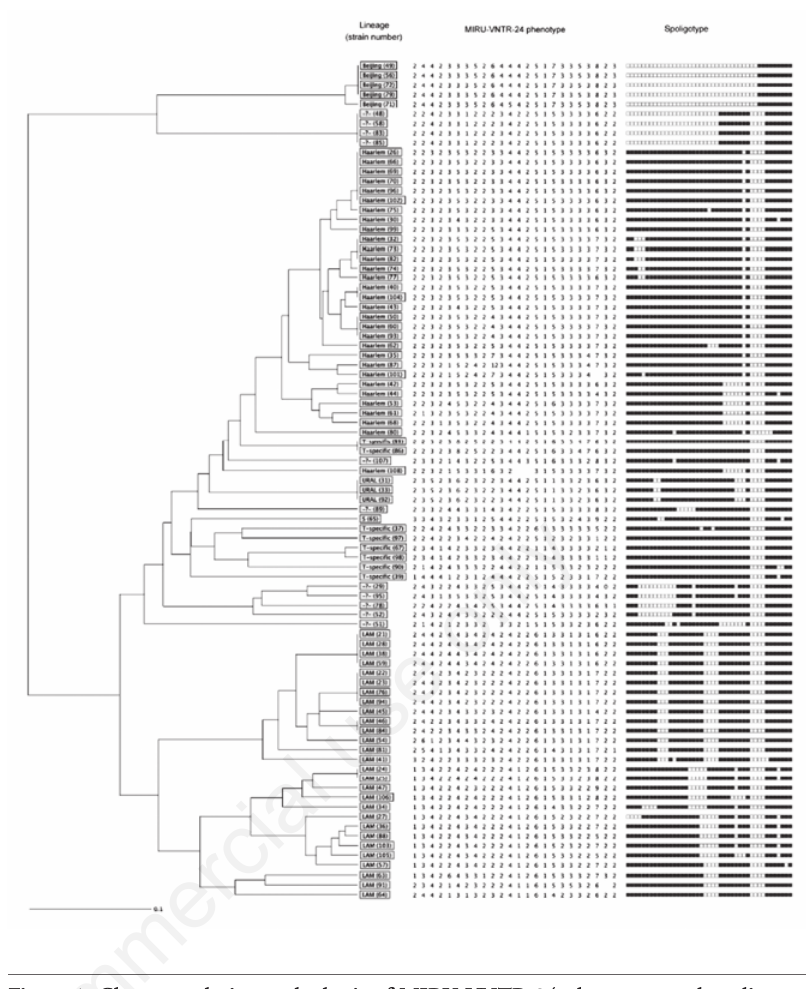
Figure 1. Cluster analysis, on the basis of MIRU-VNTR-24 phenotype and spoligotype, of Mycobacterium tuberculosis strains isolated from 87 Peruvian